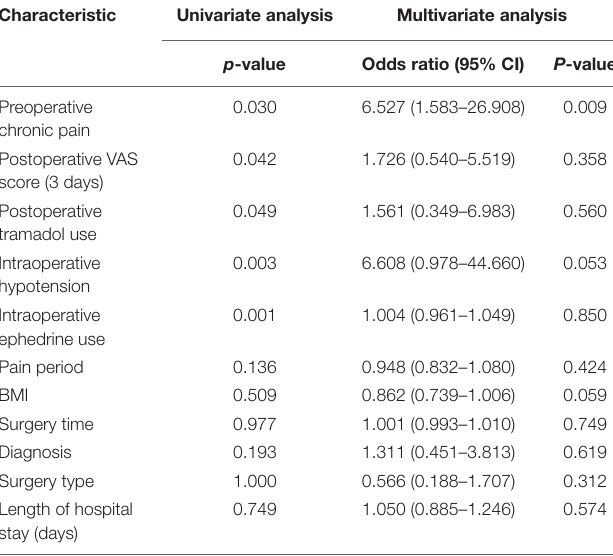
TABLE 4 | Logistic analysis for the POCD occurred at 7 days after surgery.